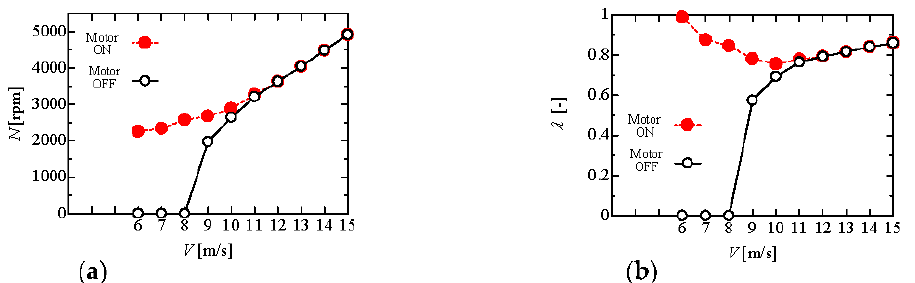
Figure 4. Starting characteristics of a single 3-D-printed experimental rotor: ( a ) rotational speed vs. uniform velocity; ( b ) tip speed ratio vs. uniform velocity.